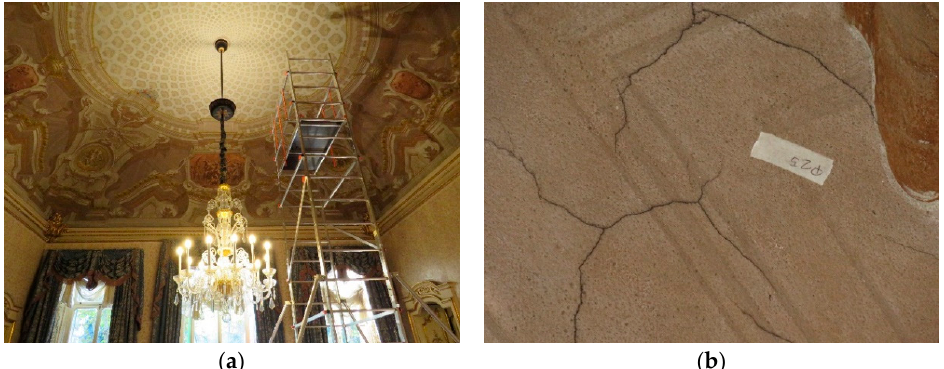
Figure 3. ( a ) Giunta room at Birago Palace; ( b ) cracks branched in the decorated plaster of the masonry vault in the Giunta room.